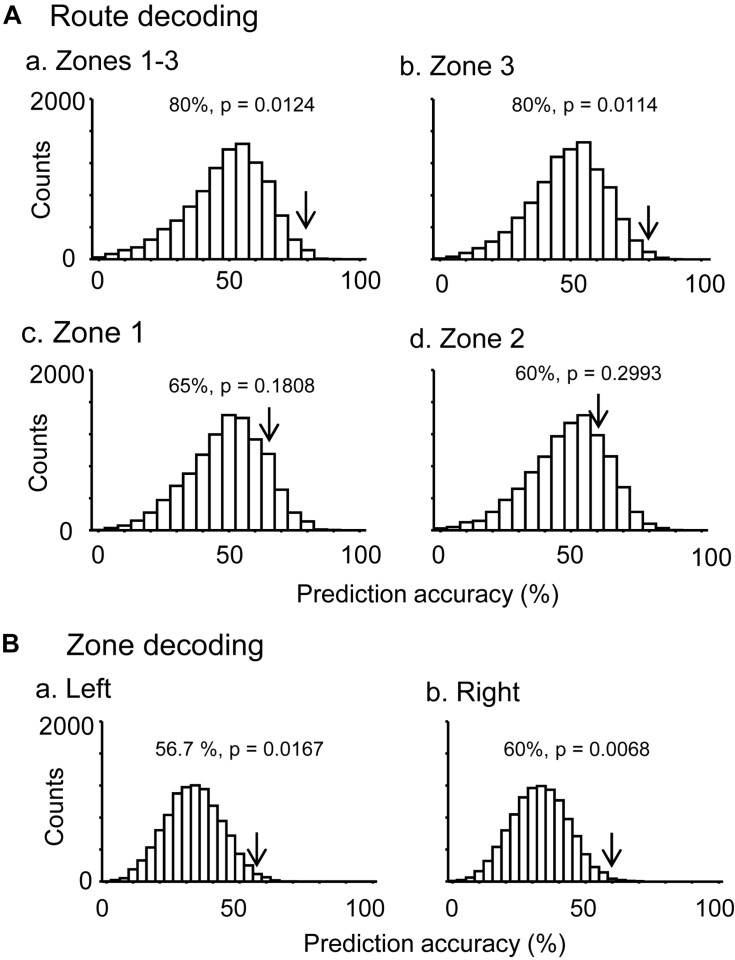
Bayesian decoding of overlapping path segments from ensemble place-related activity. (A) Route decoding from place-related activity in zones 1–3 (a), zone 3 (b), zone 1 (c), and zone 2 (d). (B) Zone decoding from place-related activity in the left (a) and right (b) routes. The arrow in each histogram indicates the actual prediction accuracy, while the histogram indicates the chance level distribution obtained using the “bootstrap” procedure (10,000 repetitions). The p-value for each prediction accuracy was calculated as the ratio of the count of the values ≥ the actual prediction accuracy in the chance.